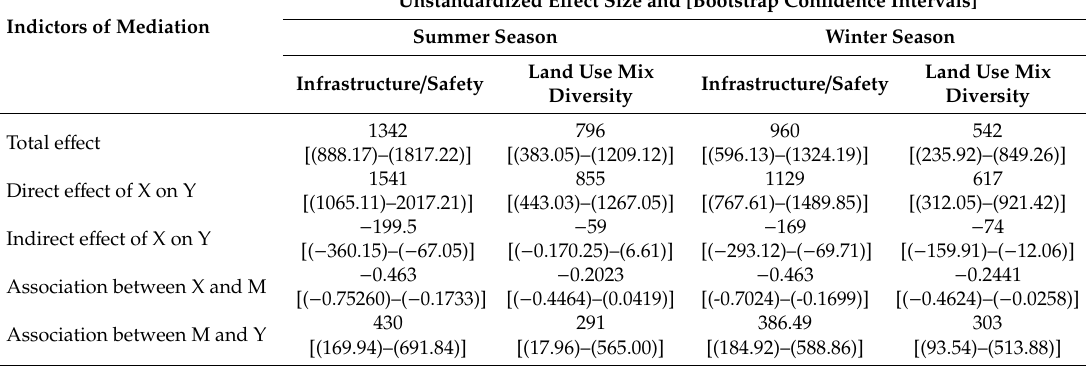
Table 5. Partial mediation e ff ects of identified motivational regulation on the number of steps taken in the summer and winter